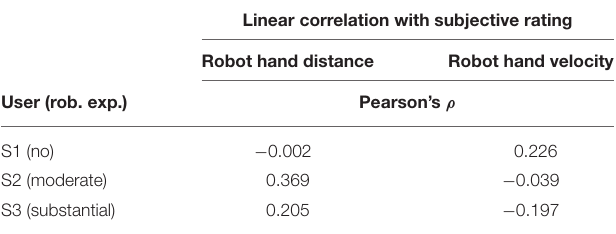
TABLE 2 | Linear correlation of robot distance and velocity with subjective ratings. Linear correlation with subjective rating Robot hand distance Robot hand